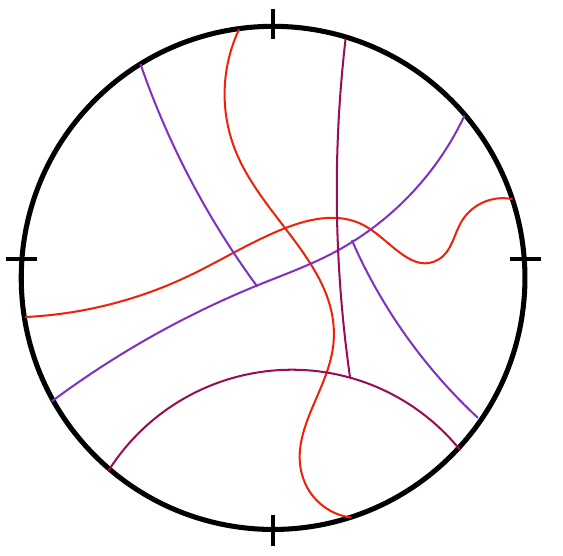
Figure 3 . Three examples of hyperthreads in H consisting of a single 3-thread and two 4-threads. Note the 4-threads can have either 1 or 2 branching